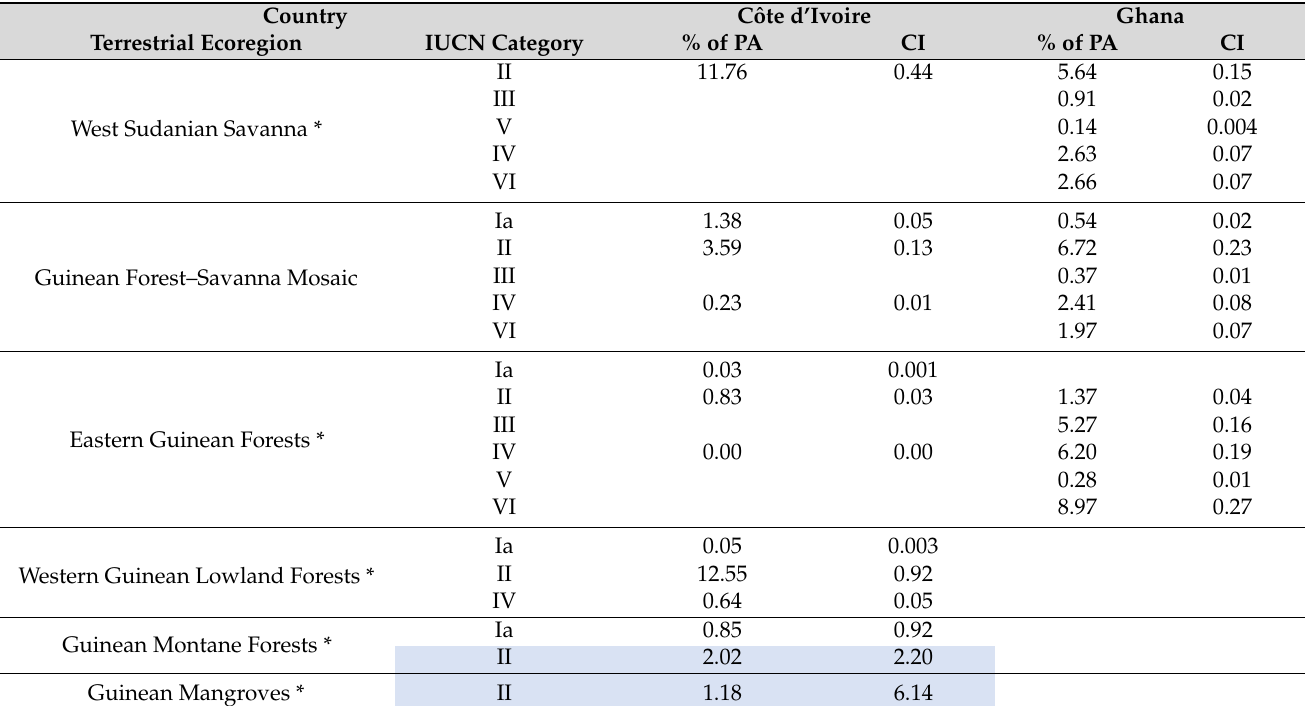
Figure 2. The protected areas and slope classes in ( a ) Côte d’Ivoire and ( b ) Ghana, West Africa. Red circles indicate high–slope areas. Table 4. The comparison index (CI) for IUCN protected area categories and their percentage land areas of the ecoregions in Côte D’Ivoire and Ghana. Blue highlighting indicates good representation (CI > 1), * = Global 200.